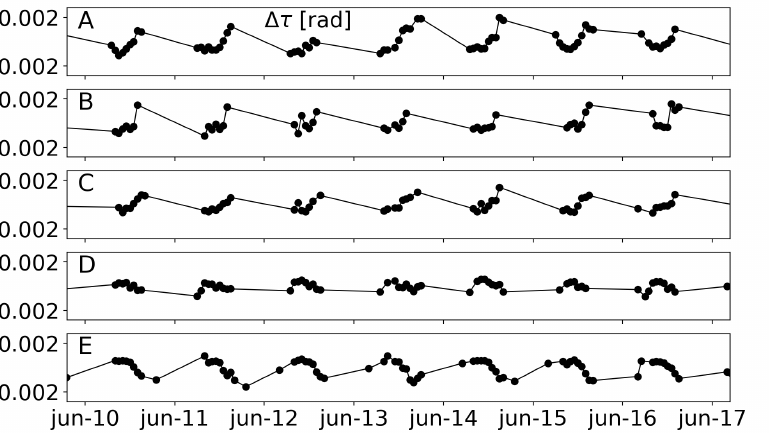
Figure 14. Time evolution of the demeaned tilt, ∆ τ , for the five cameras ( A – E ) of CFA1 in 7 summer days of